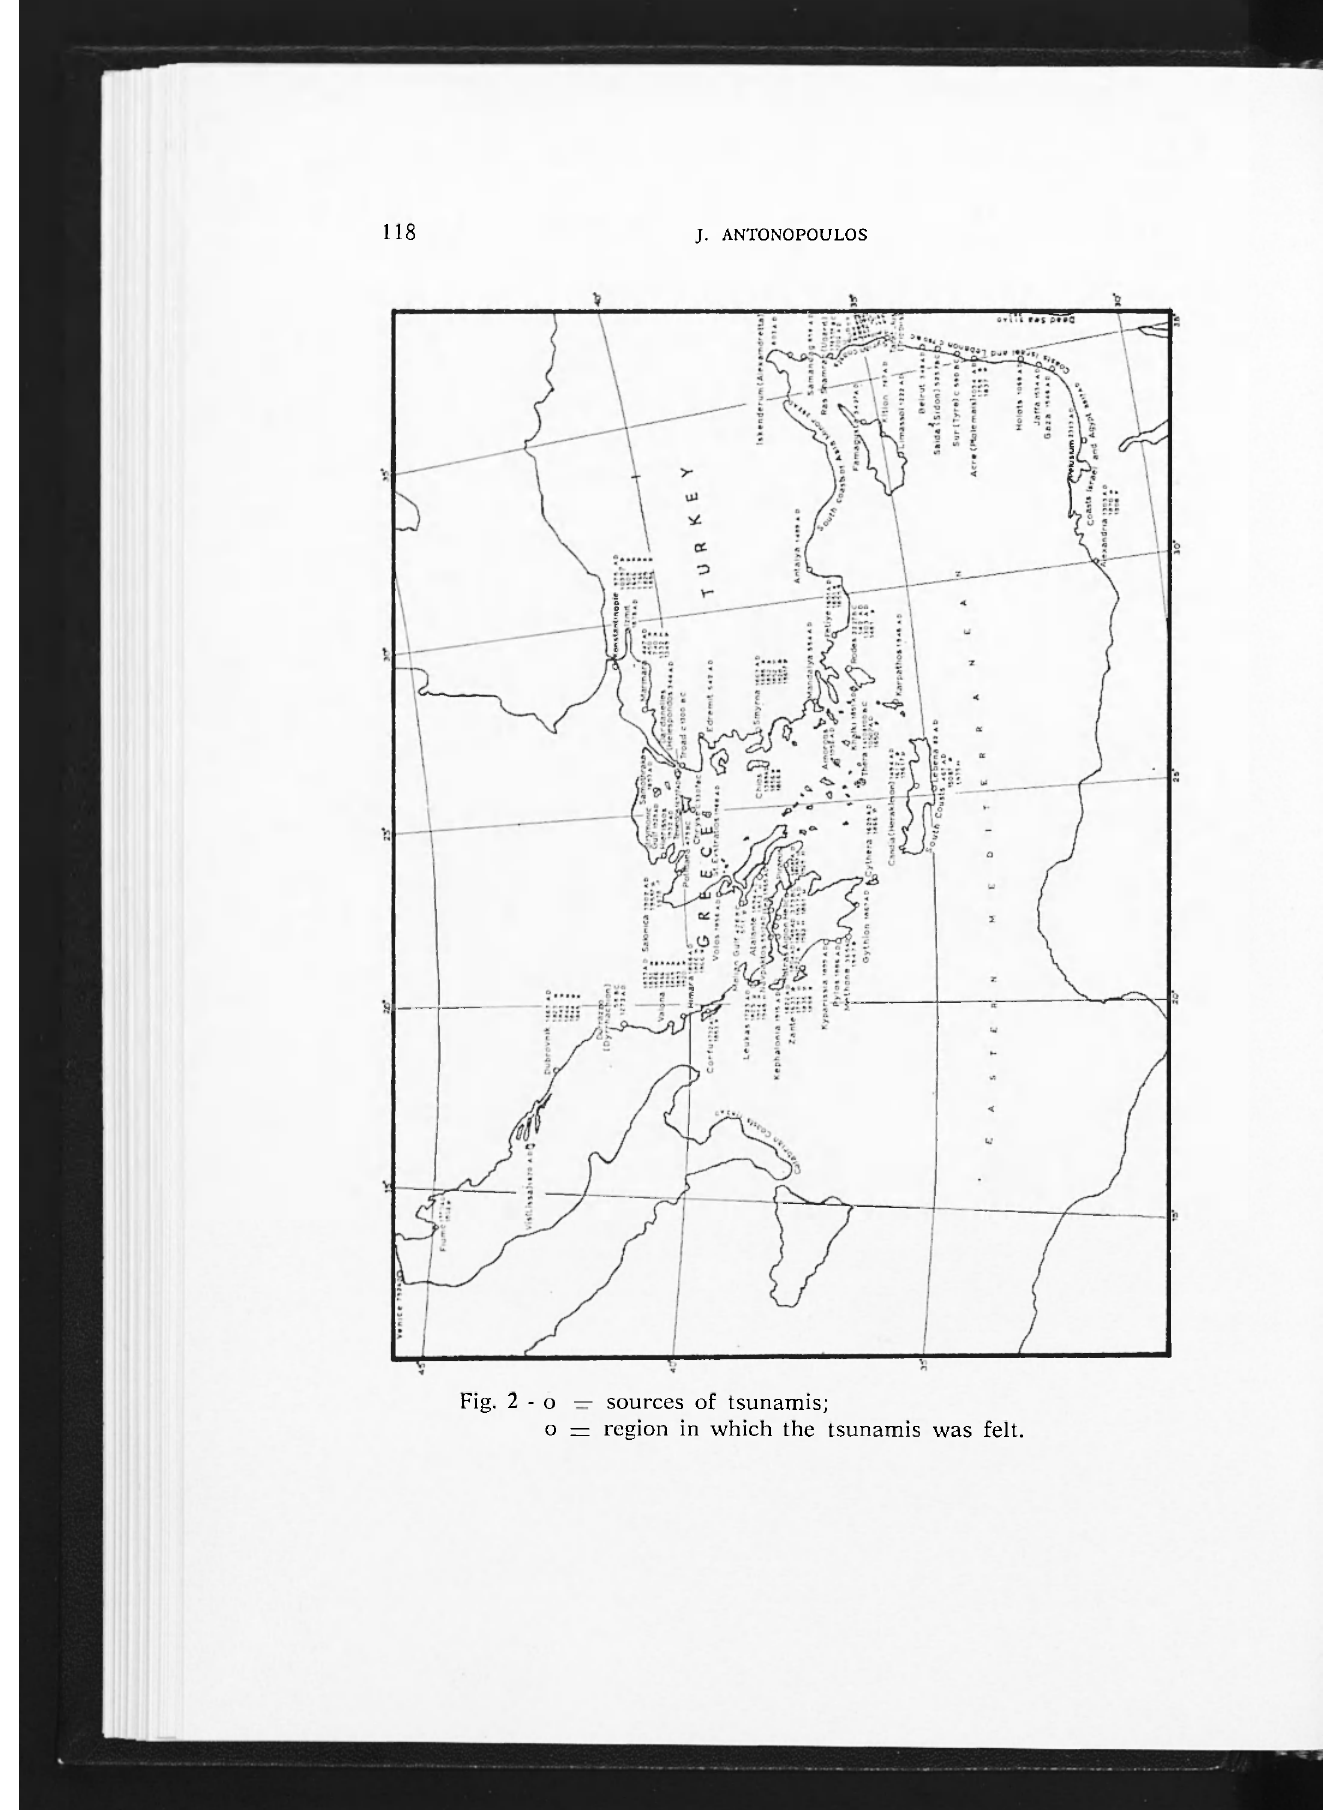
Fig. 2 - o — sources of tsunamis; o = region in which the tsunamis was